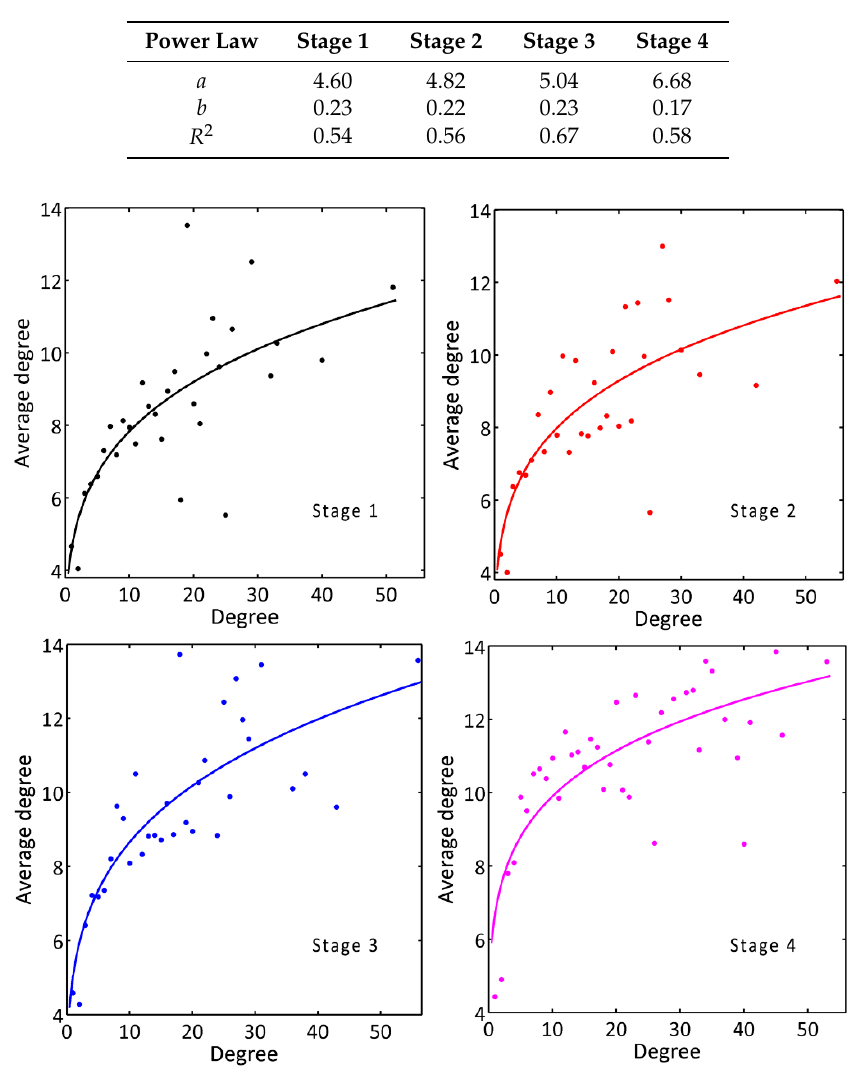
Figure 9. Degree–degree correlation.